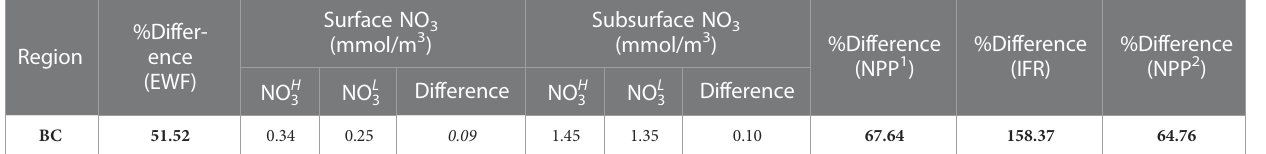
TABLE 4 Changes to seasonal EWF (%), NO 3 (mmol/m 3 ), NPP (g C/m 2 /month) and IFR (%) in high and low years in the BC.